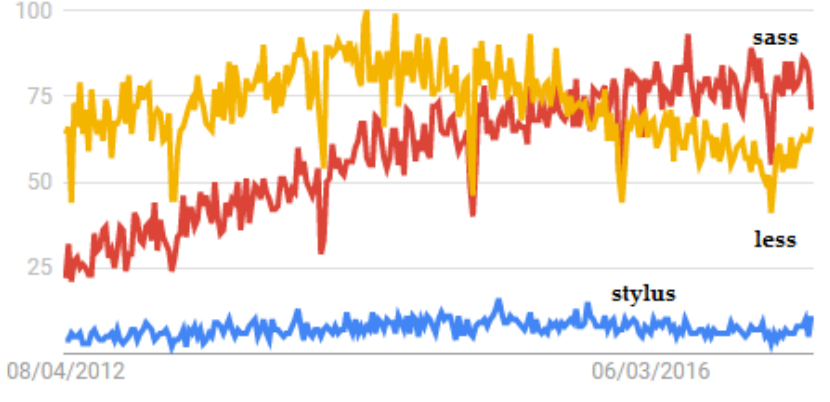
Figure 2. Interest over time on SASS, LESS and Stylus preprocessors—Google